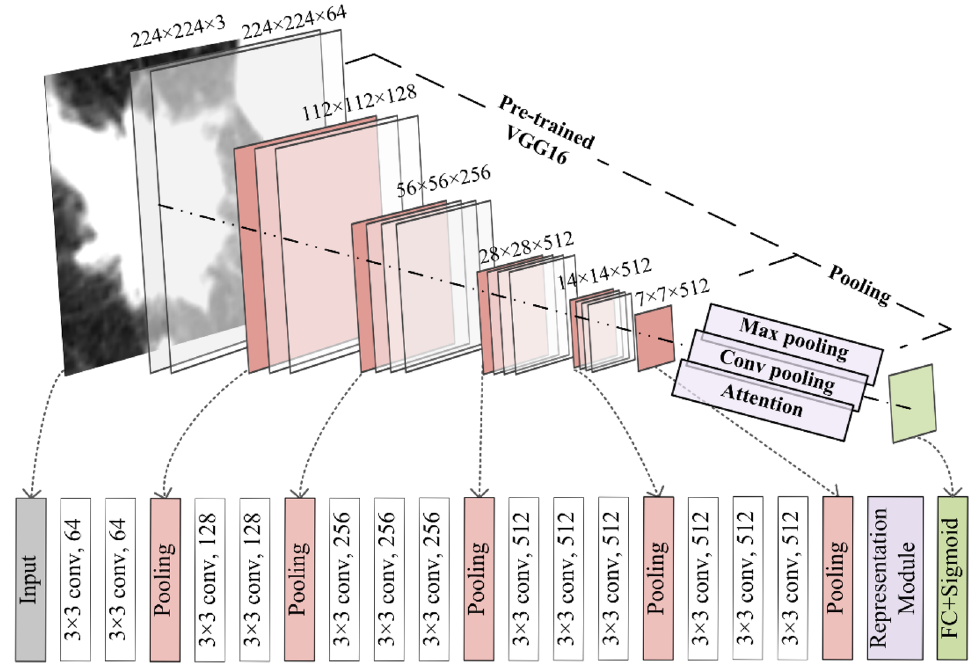
Figure 2. Structure of the pre-trained VGG16 for feature